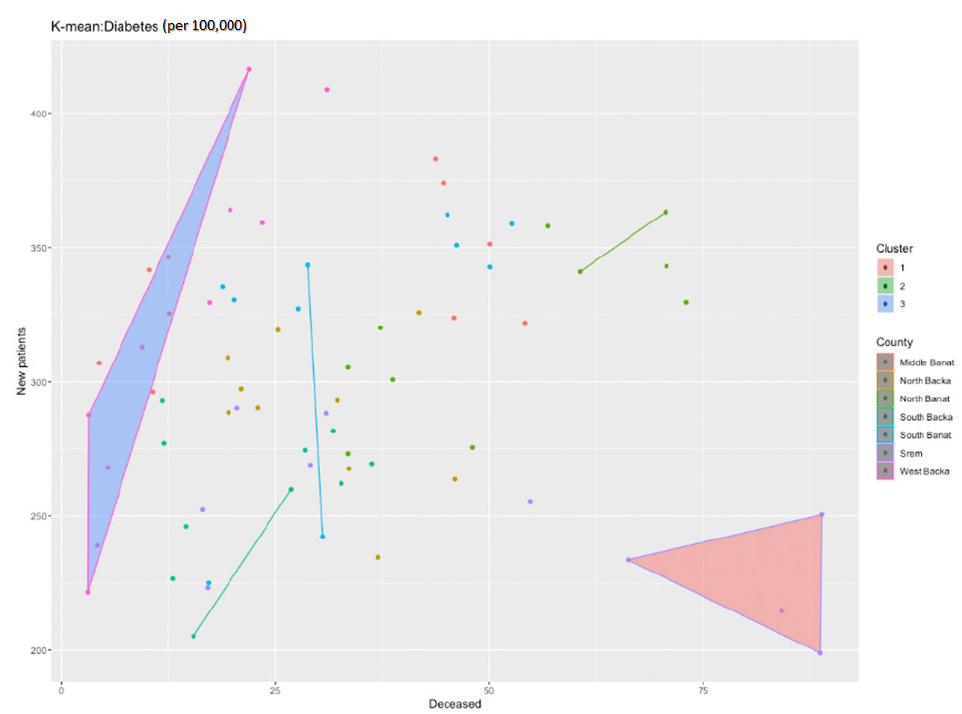
Figure 17. Identification of clusters during the diabetes analysis.